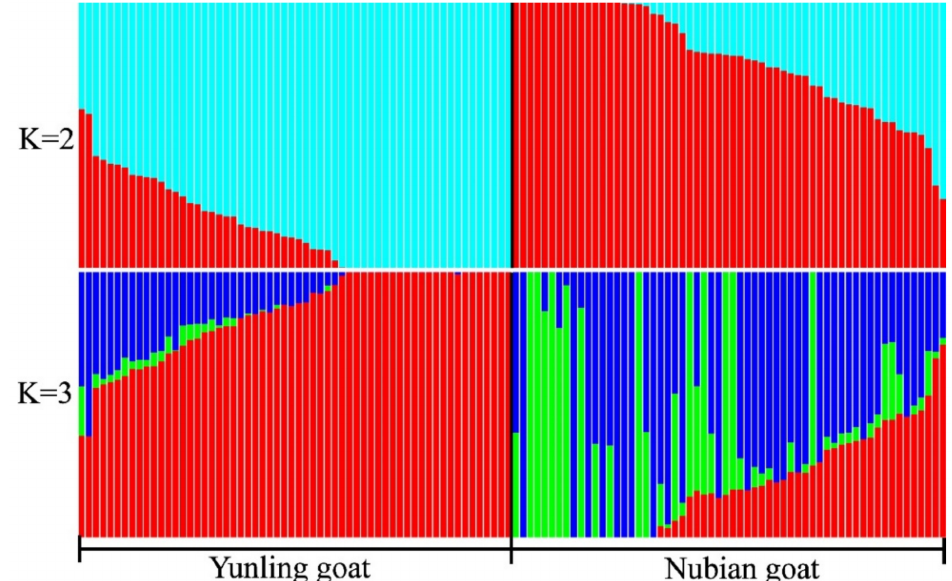
Figure 2. The population structure of Yunling goat and Nubian goat ranges from K = 2 to K = 3. (Different colors are used to distinguish different components of population